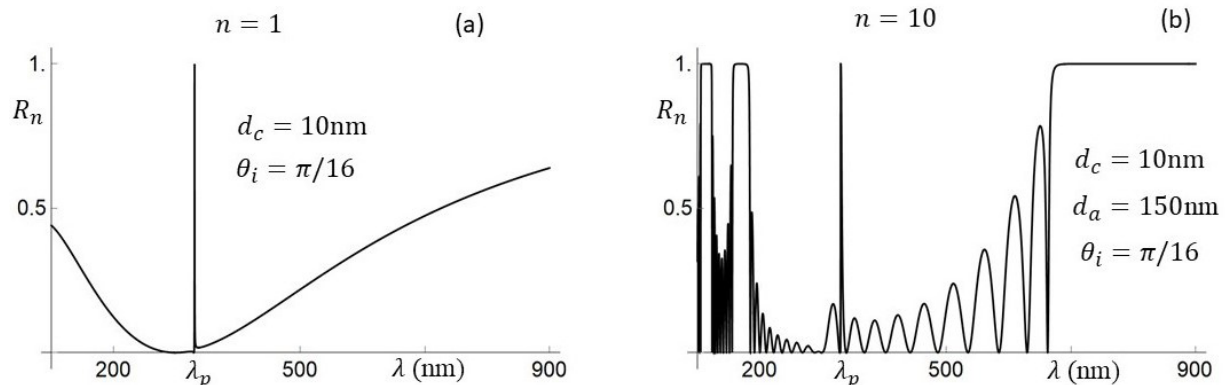
Figure 13. The reflection coefficient R n as a functions of the wavelength λ . In subfigure ( a ) for a single layer of silver. In subfigure ( b ) for a metallic superlattice with n = 10. At the plasma wavelength λ p , we see a characteristic Fano-like resonance, due to the interference between propagating and evanescent modes.